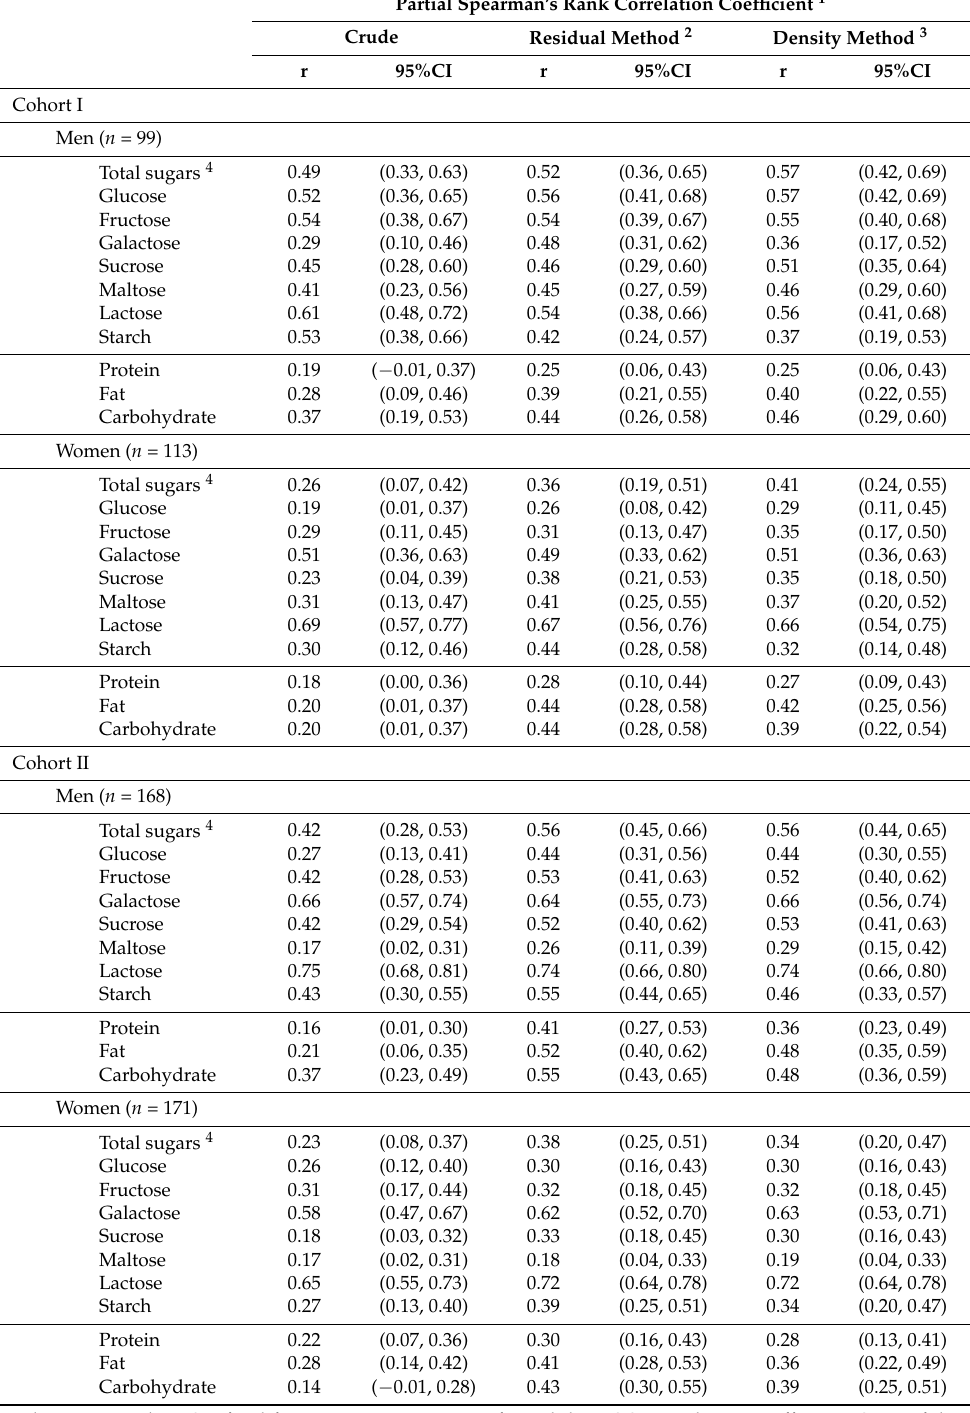
Table 4. Partial Correlations between FFQv and DR for 28 or 14 days